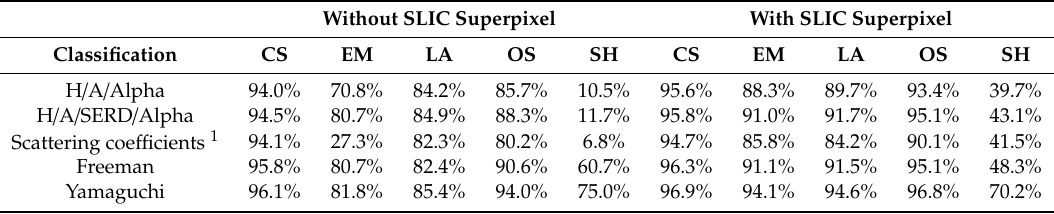
Table 5. Mean Intersection over Union (MIoU) result on each classification of polarized parameters